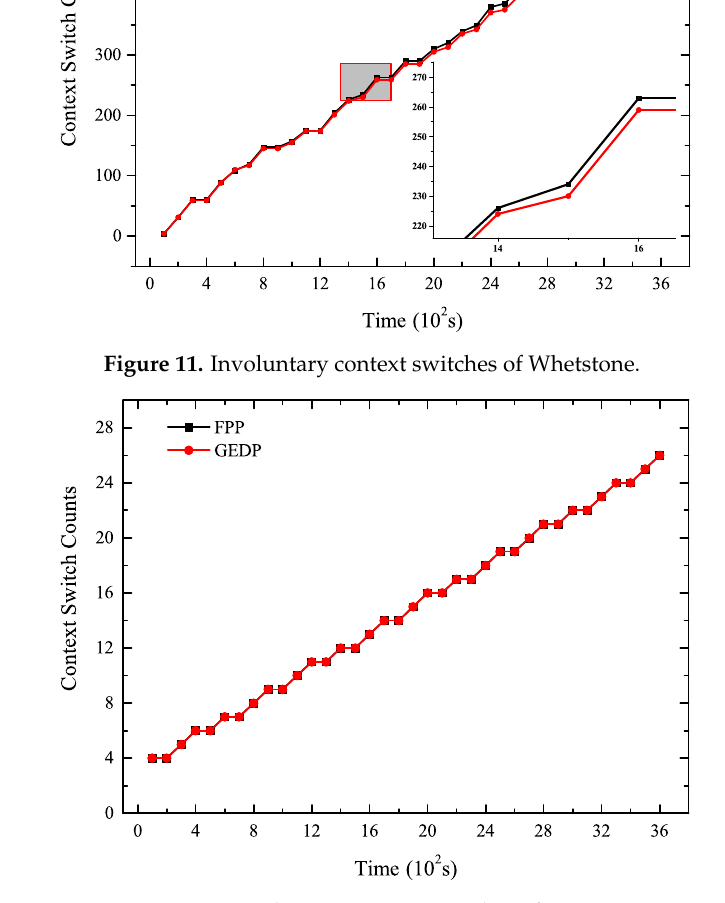
Figure 12. Voluntary context switches of